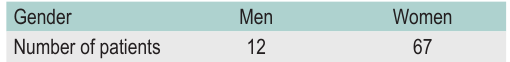
TABLE 2. Presentation of prevalence of the billateral primary gonarthrosis in both gender in the clinics “Praxis”.